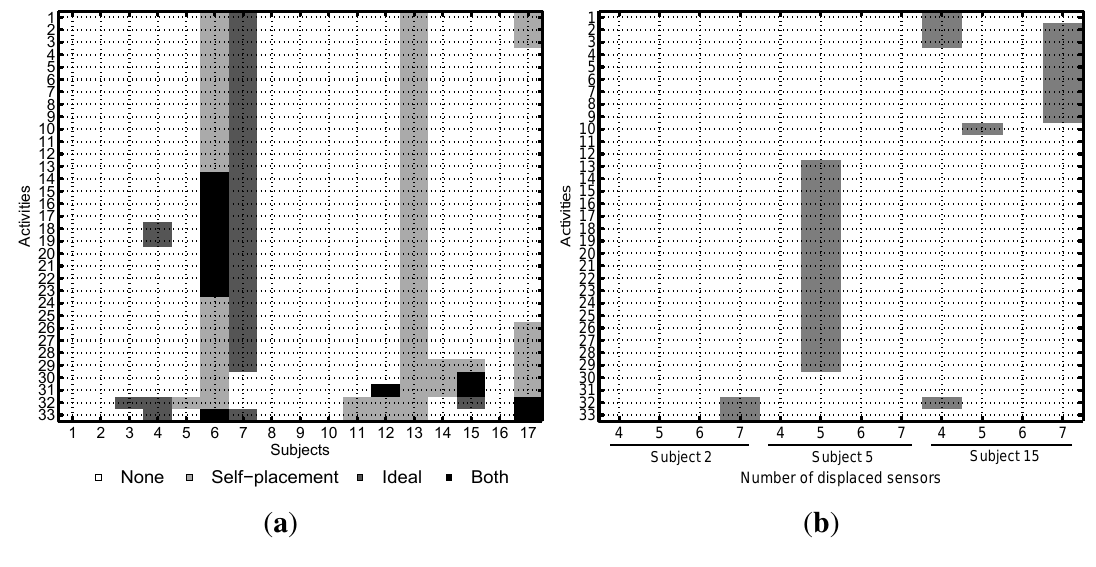
Figure 4. Missing activity data for each particular subject (shading spots). ( a ) For ideal and self-placement conditions: the legend identifies the corresponding sensor deployment (both ≡ self-placed and ideally-placed). ( b ) For the induced-displaced condition: only Participants 2, 5 and 15 were considered.